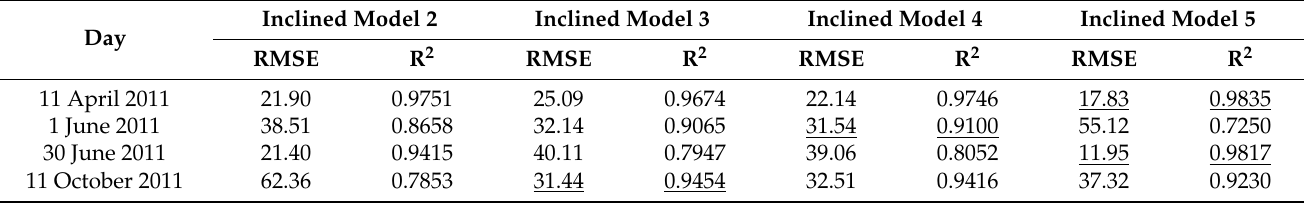
Inclined Model 2 utilized the Liu and Jordan isotropic model; Inclined Model 3 utilized the Temps and Coulson anisotropic model; Inclined Model 4 utilized the Klucher anisotropic model; Inclined Model 5 utilized the Hay anisotropic model; RMSE, root mean square error (W/m 2 ); R 2 , determination coefficient. The best results for each day are